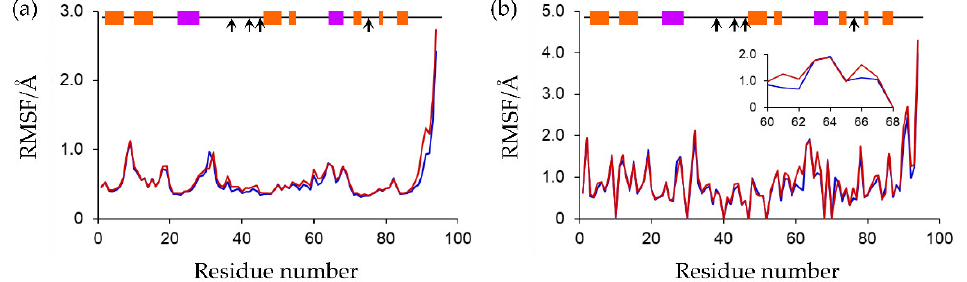
Figure 9. RMSF plot of ( a ) main-chain heavy atoms and ( b ) side-chain heavy atoms. RMSF values of side chains of Gly residues were taken as 0. RMSF values of side-chain heavy atoms of residues 60‒68th are presented in the inner panel. Plots of the oxidized and reduced Fds are presented in blue and red, respectively. In the horizontal bars at the top of the plots, α-helices and β-sheets are indicated in purple and orange. The positions of the ligated Cys residues are indicated by arrows.